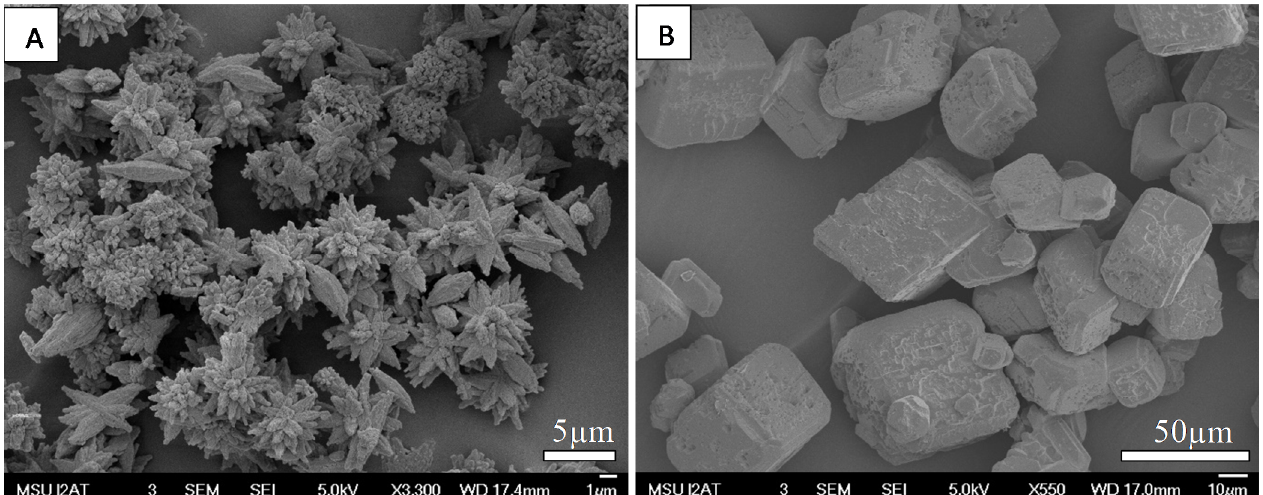
Figure 3. Secondary electron SEM images of initial aragonite samples and solid products of ( A ) initial Mg-bearing aragonite grown at room temperature, aragonite spherulites about ~5 µm in diameter, and ( B ) rhombohedral calcite crystals about 50 µm in diameter, a transformation product after hydrothermal treatment at 184 C for 40 h.